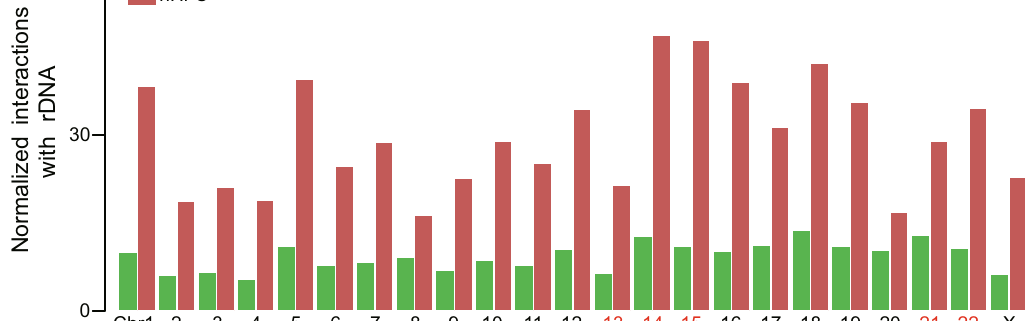
of trans interactions among the 5 NOR-bearing chromosomes ( n =4 chromo- somes). e Number of rDNA-related interactions captured by insitu Hi-C and nHi-C. f Percentage of cis (rDNA-rDNA) and trans (rDNA-other genome regions) rDNA interactions in nHi-C. g Cis interaction heatmap of rDNA repeat units from nHi-C data. h The normalized number of rDNA-associated interactions in different chromosomes from in situ Hi-C and nHi-C data. The 5 NOR-bearing chromosomes were labeled in